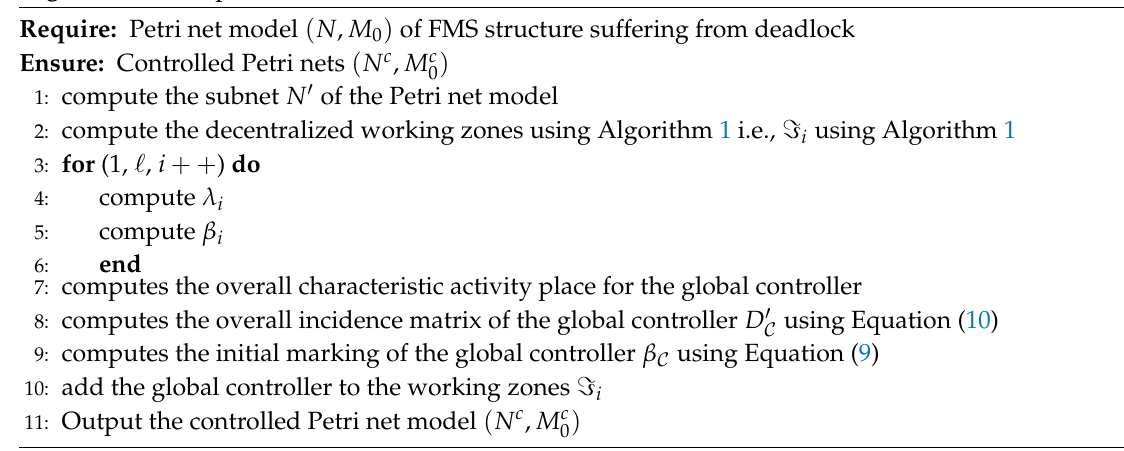
Algorithm 2 Computation of decentralized